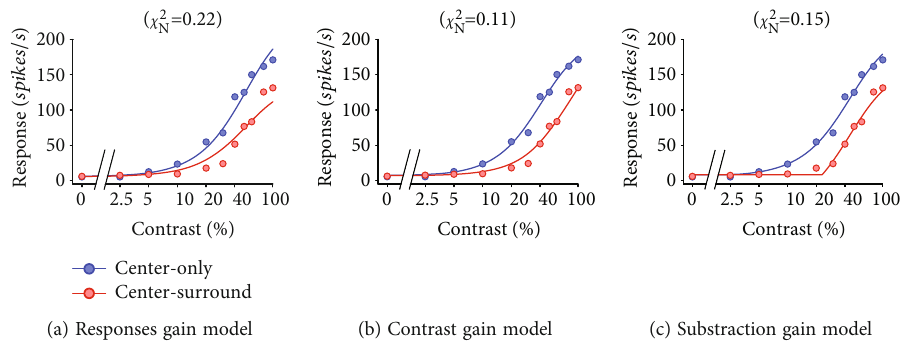
Figure 9: Responses and fi ts of a sample neuron to models accounting for surround suppression through di ff erent mechanisms. Red and blue circles and curves represent the contrast response functions and the model fi tting curves with and without surround stimuli.